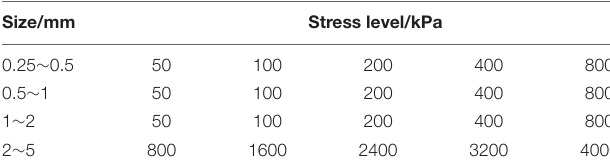
TABLE 2 | Test plan for the coral sand.